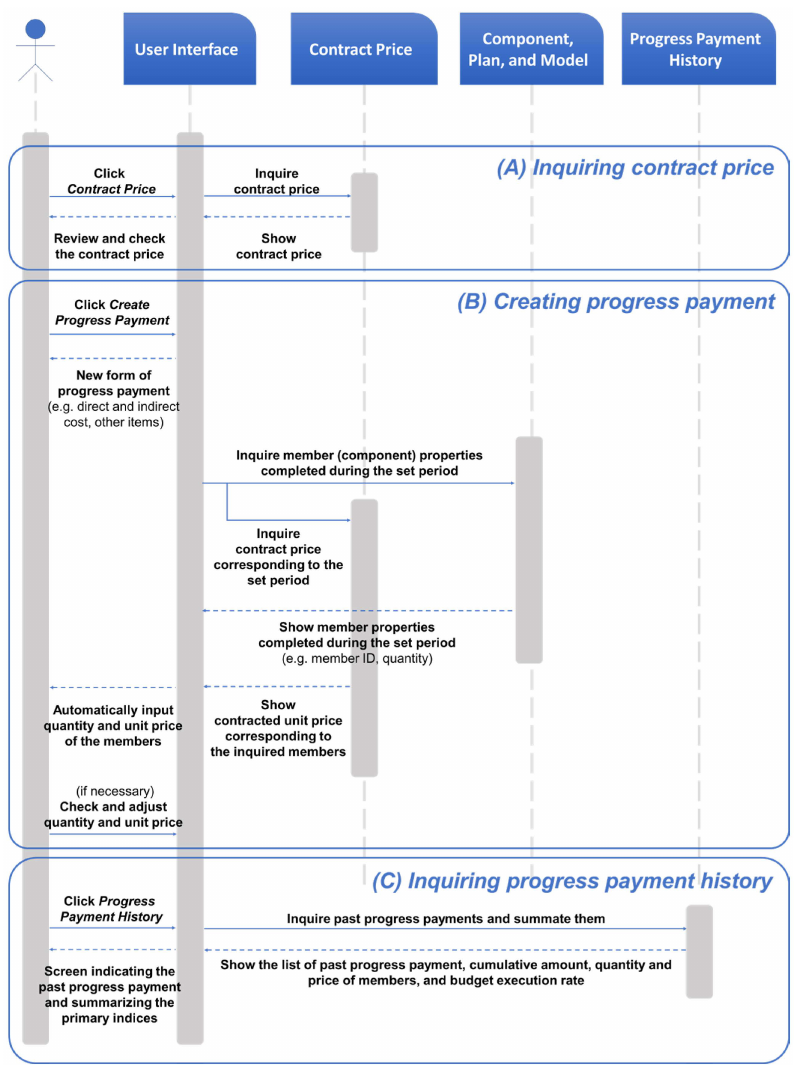
Figure 7. Sequence diagram for progress payment